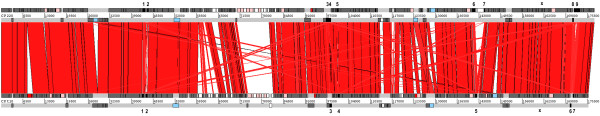
Genome alignments of CP220 and CPt10. Nucleotide alignment of the virulent bacteriophages CP220 (top) and CPt10 (bottom) generated using the Artemis Comparison Tool (ACT). The CDS regions are indicated by bars top and bottom showing the 'forward' and 'reverse' strands. CDS regions are coloured according to the following key: grey - areas of nucleotide identity, white - significantly different CDS regions present in only one of the genomes, solid black - repeat regions (numbered according to the current genome annotation), red - DNA modification proteins, blue - insertion elements, pink - radical SAM proteins. Red bars indicate regions of sequence homology, the diagonal lines link multiple repeat regions in both genomes indicating the conserved nature of these sequences throughout both genomes.